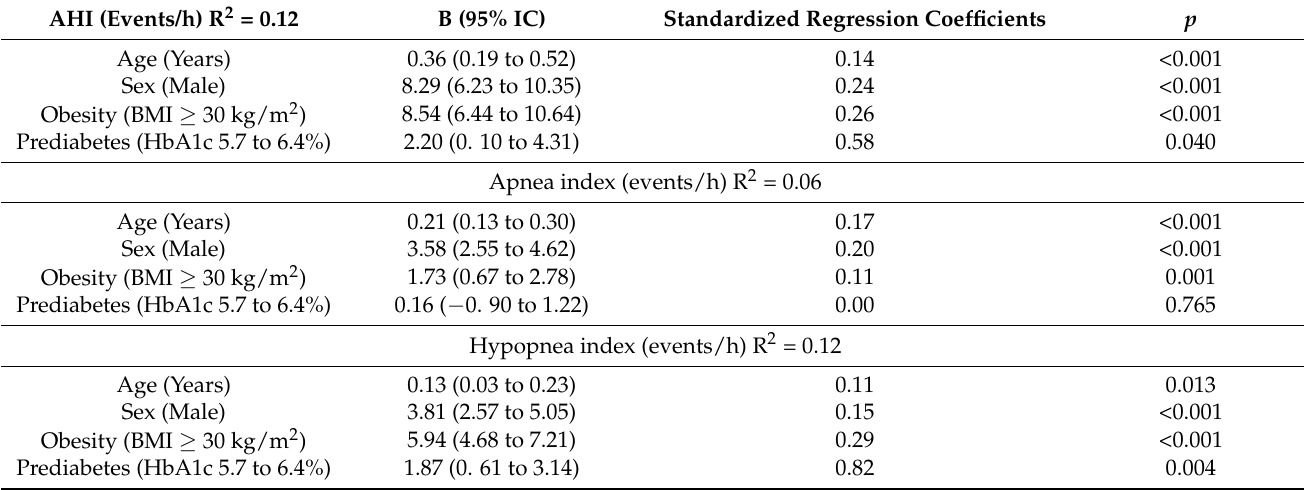
Table 4. The multiple linear regression model for the AHI, apnea index and hypopnea index. AHI (Events/h) R 2 =